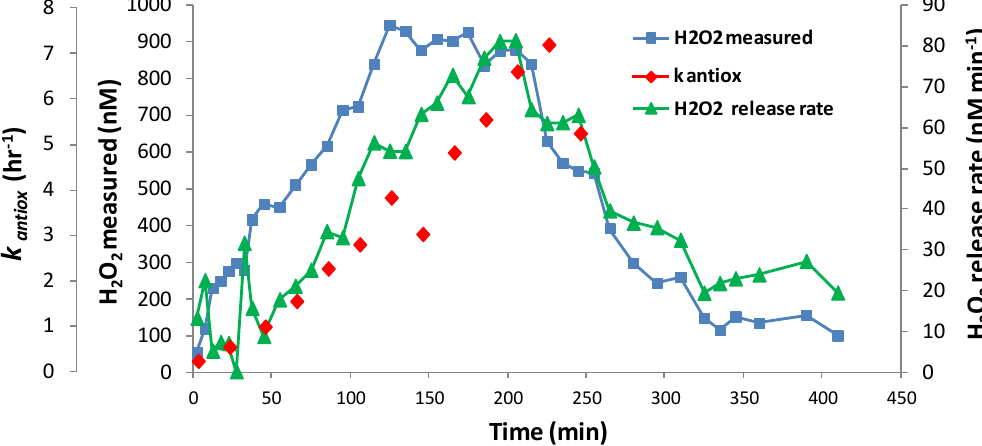
Figure 3. H 2 O 2 and antioxidant activity release kinetics in a long incubation. A representative 7h long experiment showing the accumulation of antioxidant activity (red diamonds) and changes in H 2 O 2 concentrations (blue squares) over time in the coral incubation water. These frequent measurements enabled the calculation of actual H 2 O 2 release rates by the coral (green triangle, Eq.